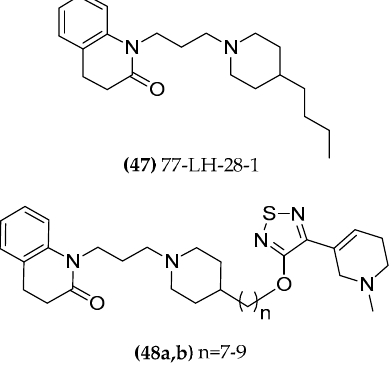
Figure 25. Dual-active AChE inhibitor/ mAChR agonist compounds.